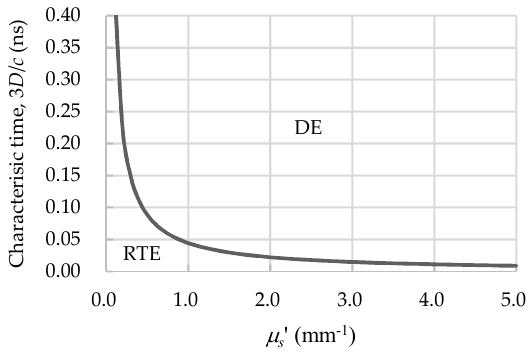
Figure 2. Regime map for the DE and the RTE.